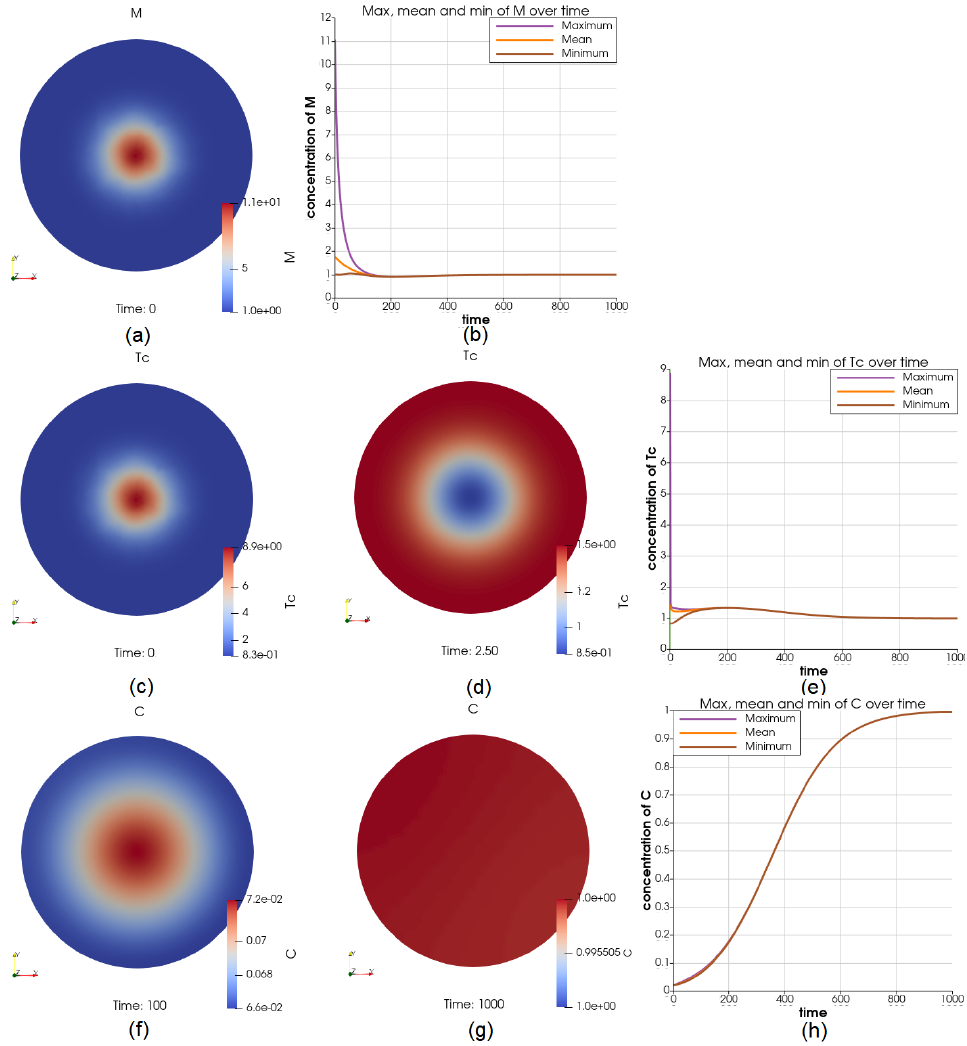
Figure 5. Illustrations for the case of more M and T c in the middle initially. Sub-figure ( a , c ) shows the initial value of T c and M through the domain, respectively; ( d ) shows T c at t = 2.5, which marks a drastic change in both the profile and values; the dynamics of M and T c over the whole time interval is shown in ( b , e ), respectively; the cancer cell concentrations at t = 100 and t = 1000 are shown in ( f , g ), and the dynamics of C is shown in ( h